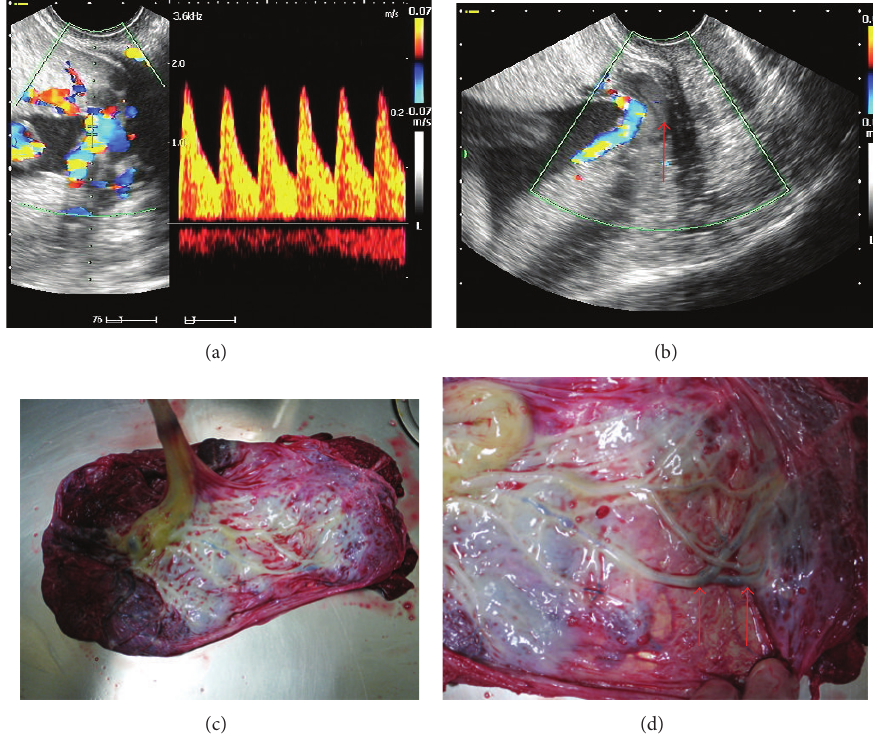
Figure 2: (a and b) Transvaginal ultrasonography revealed membranous fetal vessels passing across the cervical internal os considered to be related to a low-lying bilobate placenta. Therefore, a diagnosis of vasa previa was made. The red arrow indicates a small space between the placental vessels and the internal os. (c and d) Images of the placenta obtained by transvaginal ultrasonography. The red arrows indicate the vessels thought to be vasa